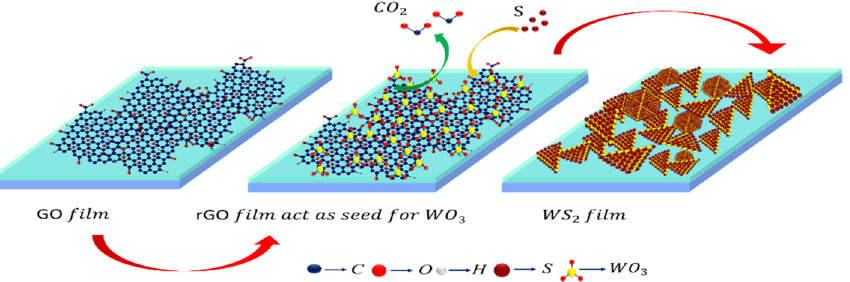
Figure 9. Schematic diagram to represent WS 2 growth mechanism on GO coated Si/SiO 2 substrate.